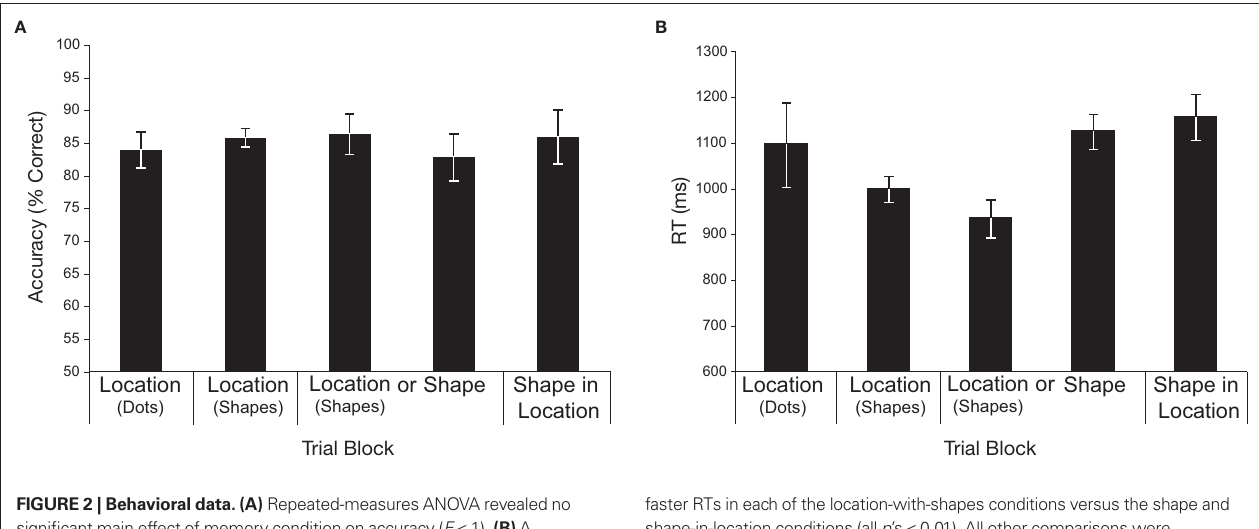
Figure 2 | Behavioral data. (A) Repeated-measures ANOVA revealed no significant main effect of memory condition on accuracy ( F < 1). (B) A repeated-measures ANOVA revealed a significant difference in RT across conditions [ F (4,40) = 5.11, p = 0.002]. Follow up paired comparisons revealed